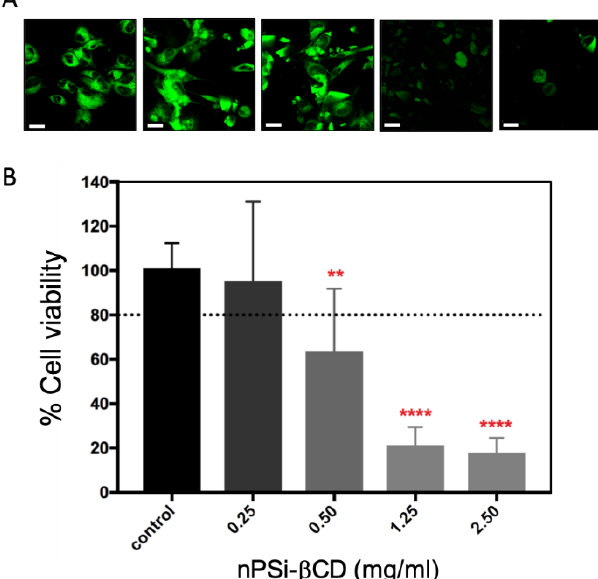
Figure 10. Cytotoxicity of HUVECs exposed to nPSi- β CD microparticles. The cells were exposed for 6 h and then cellular viability was evaluated with CellTiter-FluorTM assay and fluorescence intensity measuring was with confocal laser microscope ( A ) HUVECs exposed to nPSi- β CD microparticles. Scale bars: 20 µ m. ( B ) Viability percentage of cells exposed to composite microparticles. Unexposed cells to nPSi- β CD microparticles were used as a control. Dashed line indicates cell viability of 80%. All results are presented as the mean ± standard deviation (SD). The experimental data from all the studies were analyzed using Analysis of Variance (ANOVA) and Kruskal–Wallis test, which indicate the statistical significance when the percentage of cells viability exposed to the di ff erent microparticles concentrations are di ff erent from the control. ** p < 0.01, **** p < 0.0001. (n = 3).